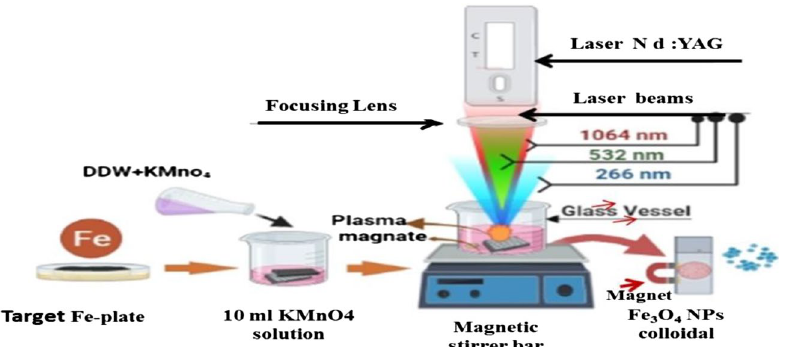
Figure 1. Schematic of the experimental setup for Fe 3 O 4 NPs prepared by LAIL with different wavelengths and KMnO 4